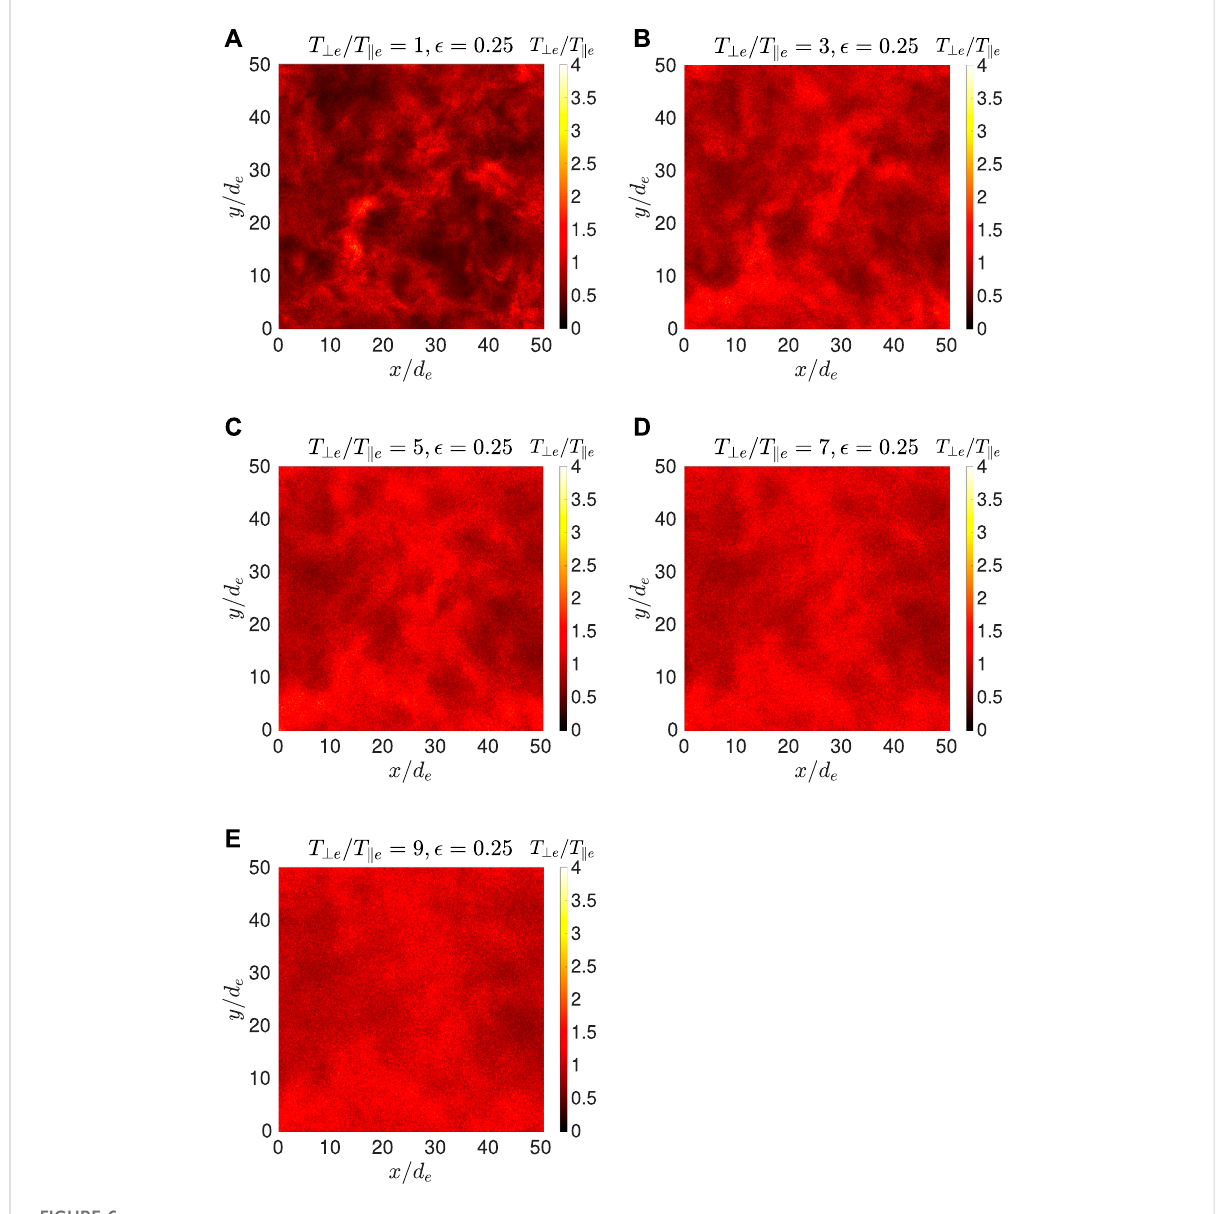
FIGURE 6 Contours of R e ( i , j , k ) on an x-y plane in the middle of the simulation box at time Ω e t ≈ 223.60 for Run B3 (A) , C2 (B) , C3 (C) , C4 (D) , and C5 (E)